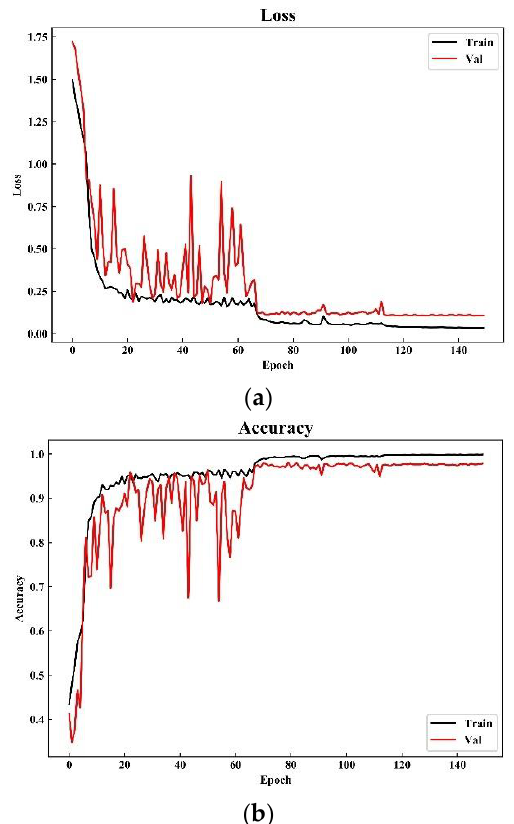
Figure 9. Loss and accuracy of training and validation set: ( a ) loss and ( b ) accuracy.